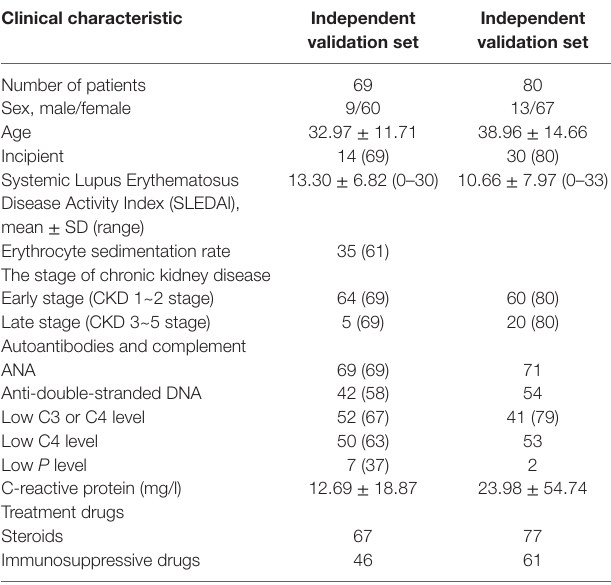
TaBle 2 | Clinical features of systemic lupus erythematosus cases on independent validation set from Wenzhou and cross-validation set from